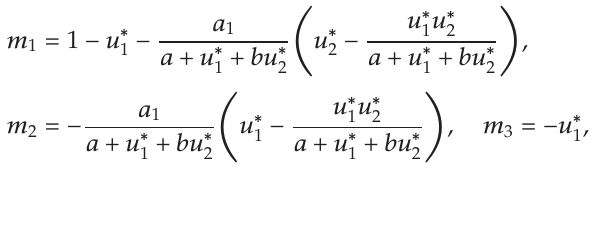
Figure 4: Trajectory portrait and phase portrait of system (cid:2) 4.1 (cid:3) with τ 2 (cid:6) 0 . 5 ,τ 1 (cid:6) 1 . 35 > τ 1 bifurcation occurs from the positive equilibrium E ∗ (cid:6) (cid:2) 0 . 32 , 0 . 96 (cid:3) . The initial value is (cid:2) 0.2,0.2 (cid:3)